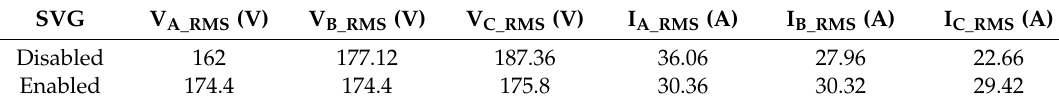
Figure 7. Three-phase voltages and currents measured at breaker B1, B2, and B3 with unbalanced loads. Table 6. Three-phase voltages and currents measured at breaker B3 with unbalanced loads.